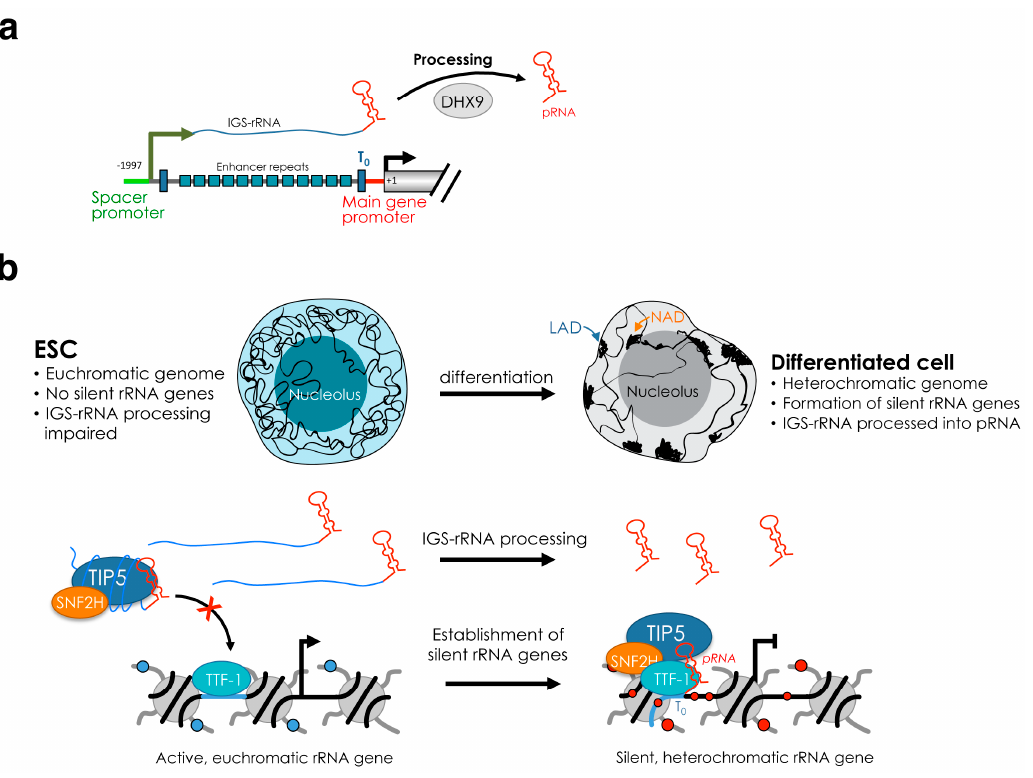
Figure 2. Regulation of rRNA gene chromatin state embryonic stem cells. ( a ) Scheme showing the synthesis of IGS-rRNA from the mouse spacer promoter and its processing into pRNA, a reaction mediated by DHX9 [57,64]. ( b ) Model showing the chromatin organization of the nucleus and nucleolus of ESCs (open, euchromatic) and differentiated cells (closed, heterochromatic). In ESCs, IGS-rRNA is not processed with consequent lack of mature pRNA [48]. IGS-rRNA impairs the association of TIP5 with TTF1 and TIP5 recruitment to rRNA genes. Consequently, all rRNA genes are kept euchromatic and active in ESCs. Upon differentiation, mature pRNA is produced and promotes TIP5-TTF1 interaction that is productive for TIP5 guiding to rRNA genes and formation of heterochromatin at nucleoli. The formation of silent and heterochromatic rRNA genes coincides with the remodeling of the genome from a euchromatic into a heterochromatic state that favors the exit from pluripotency.